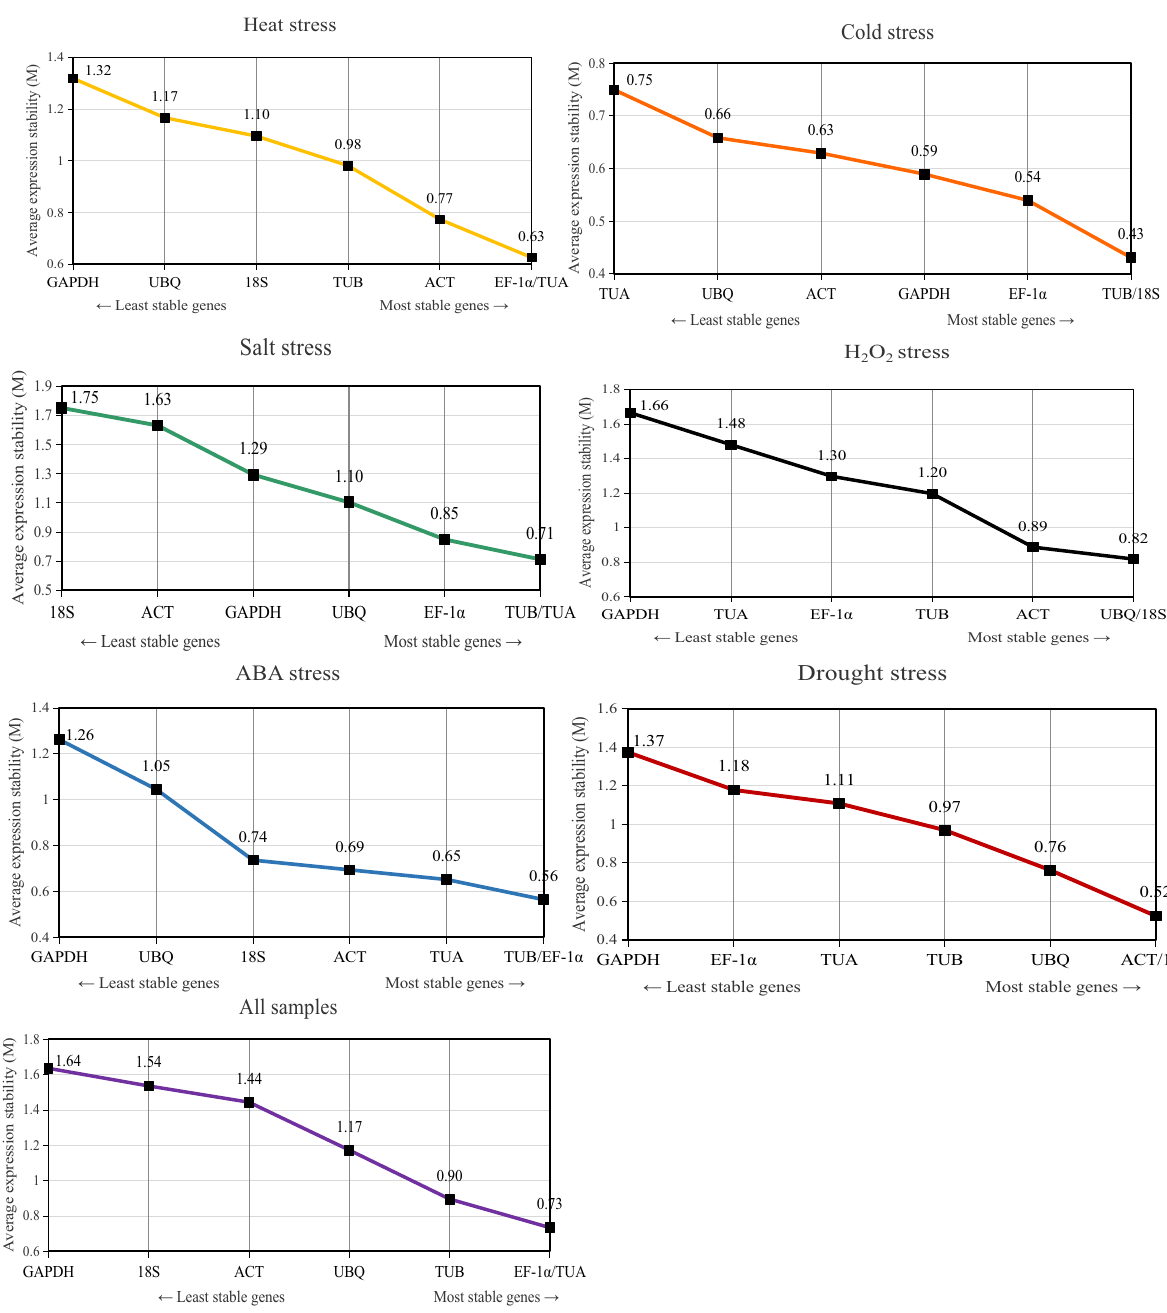
Figure 5. Expression stability of seven reference genes in luffa under different conditions based on a geNorm fered among the stress conditions. For the heat treatment, EF-1α and TUA were the most stably expressed genes, with an M value of 0.63, whereas GAPDH was the least stably expressed gene, with an M value of 1.32. For the cold treatment, TUB and 18S (M = 0.43) were the most stably expressed genes, whereas TUA (M = 0.75) was the least stably expressed gene. Regarding the H 2 O 2 treatment, the most stably expressed genes were UBQ and 18S (M = 0.82) and the least stably expressed gene was GAPDH (M = 1.66). In response to the salt treatment, TUB and TUA (M = 0.71) had the most stable expression levels, whereas 18S (M = 1.75) had the most unstable expres- sion level. For the ABA treatment, EF-1α and TUB (M = 0.56) were detected as the most stably expressed genes and GAPDH (M = 1.26) was identified as the most variably expressed gene. Following the drought treatment, the expression levels were most stable for ACT and 18S (M = 0.52) and least stable for GAPDH (M = 1.37). Overall, EF-1α and TUA (M = 0.73) were the most stably expressed genes in all samples, whereas GAPDH (M = 1.64) was the least stably expressed gene (Fig. 5).